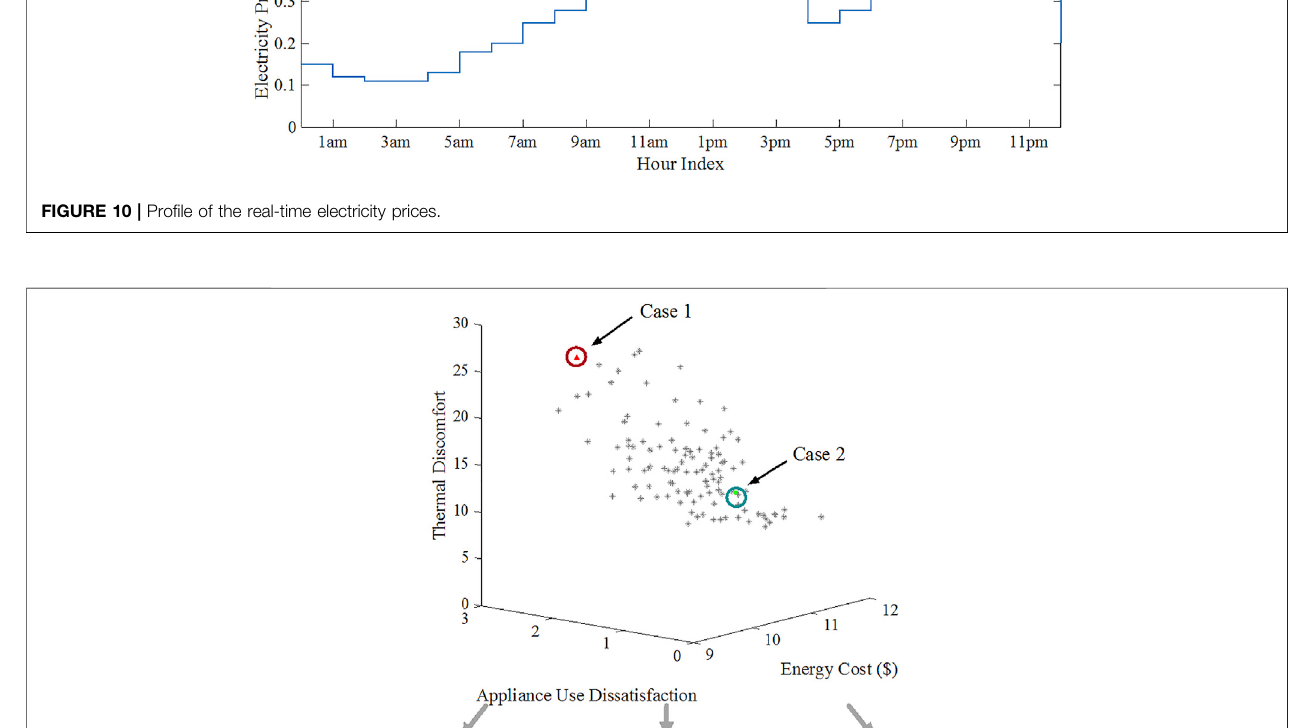
Frontiers in Energy Research |